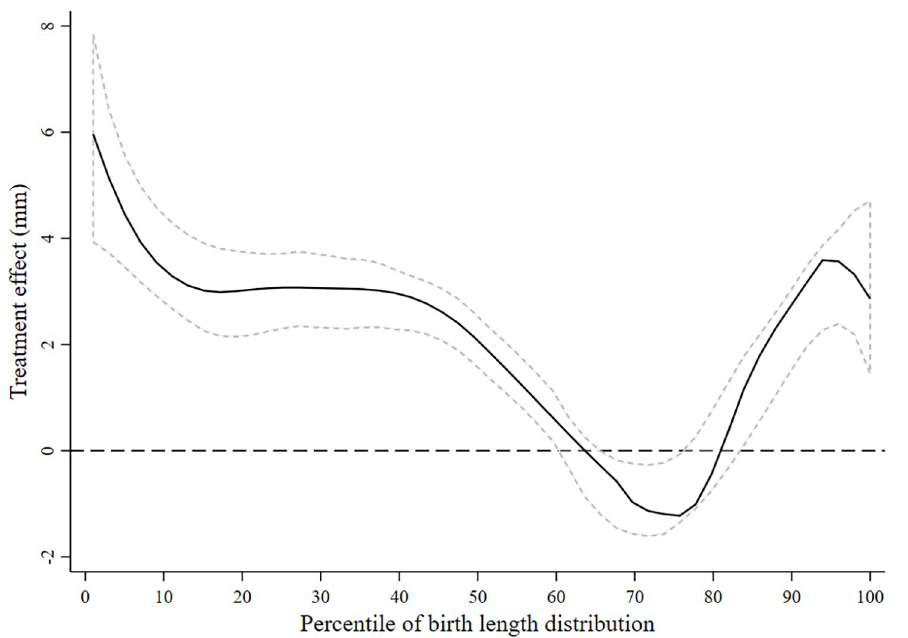
Fig 3. Treatment efficacy on birth length across the distribution of birth length. The estimated difference in birth length between the women who received the BEP supplement and IFA (intervention) and those who received only iron and folic acid (control) is shown as a function of the percentiles of birth lengths. The zero line indicates no efficacy of BEP. The positive y values indicate a higher birth length in the intervention group, and the negative y values indicate a lower birth length. The central solid black line represents the smoothed treatment efficacy, with upper and lower dashed 95% confidence bands, using complete cases. BEP, balanced energy–protein; IFA, iron–folic acid.